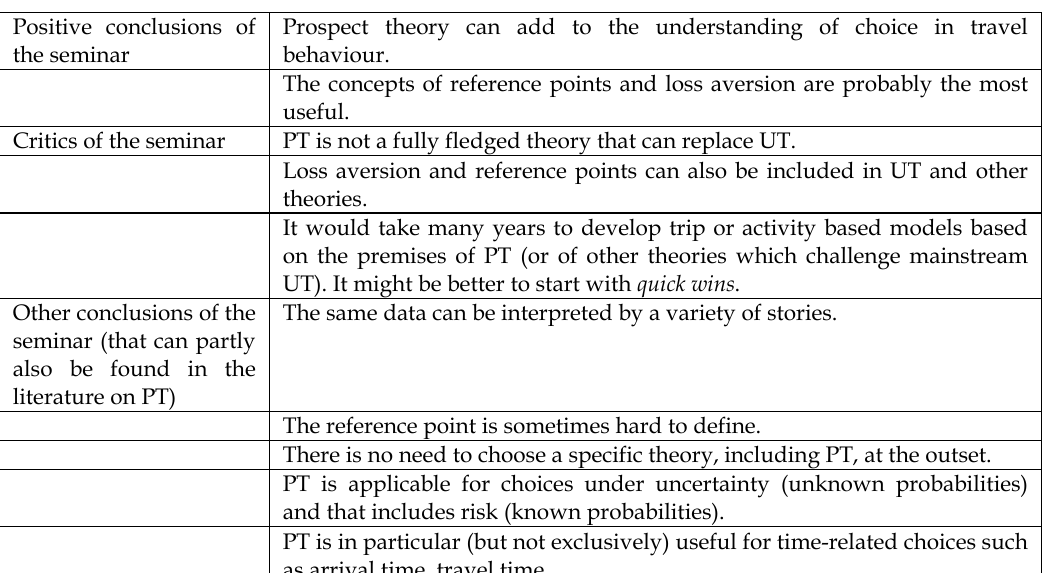
Table 2: a summary of conclusions of this